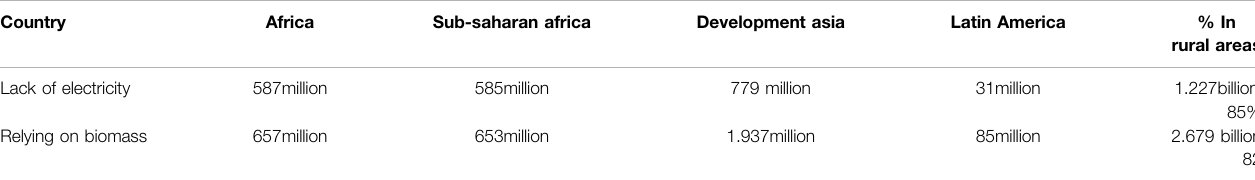
TABLE 1 | Energy poverty in rural areas at the global